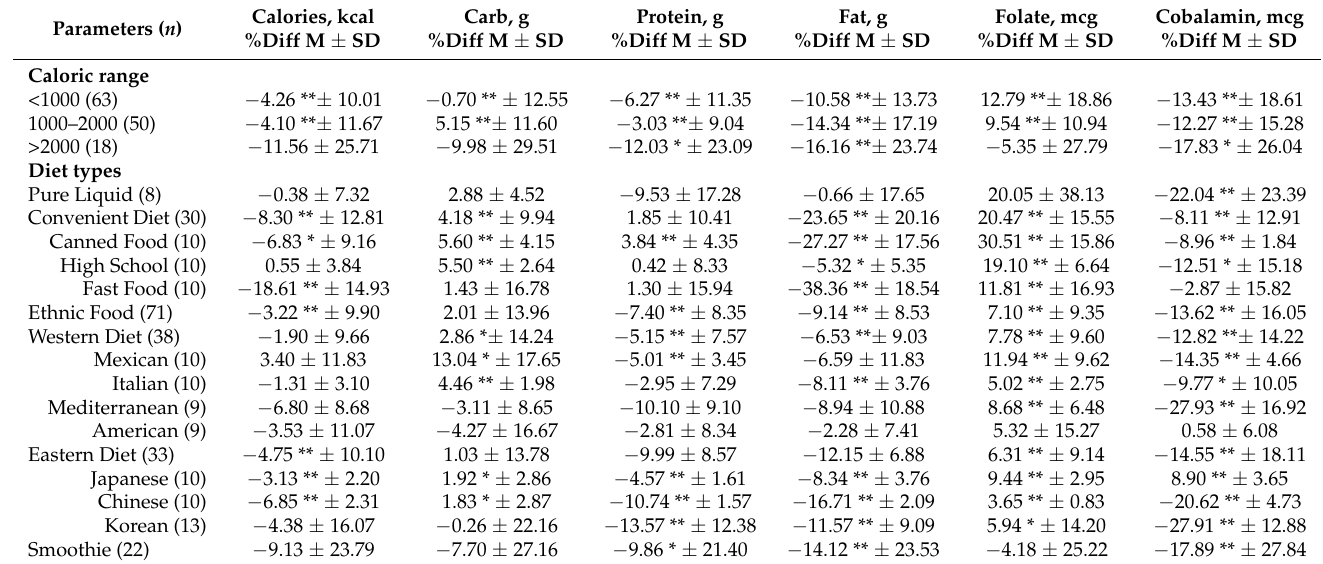
Table 2. Differences between the internet-based application and Nutrition Data System for Research per domains of caloric ranges and various diets for essential macro-and micro-nutrients ( n =